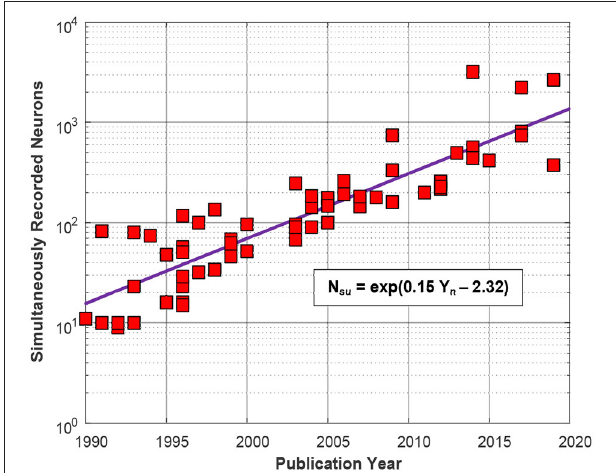
FIGURE 1 | Number of simultaneously recorded neurons, N su , over the last three decades from a selection of N 70 published works. Variable Y n is the = ordinal number of the years. The coefficient of determination of the fitting model is R 2 84 % =